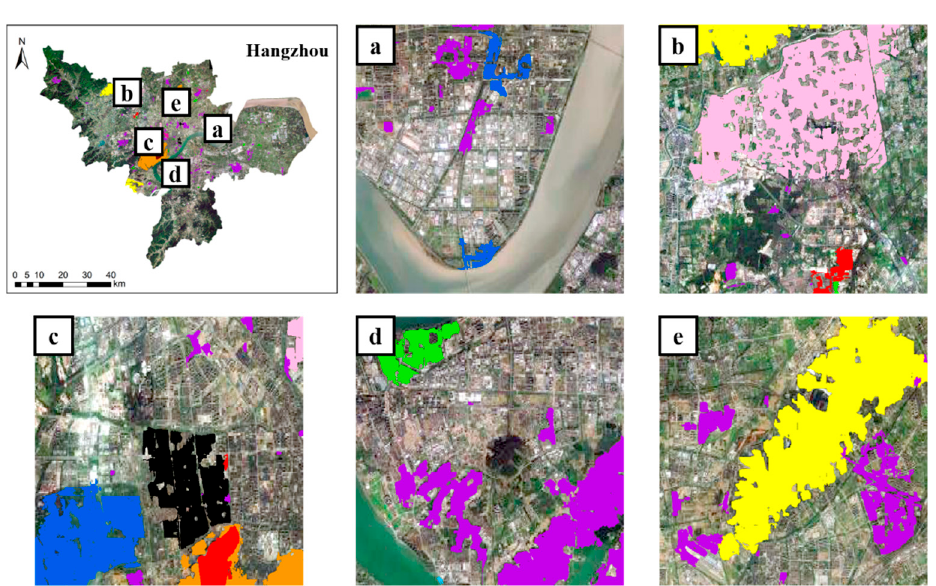
Figure 16. Local details of Hangzhou urban park map ( a – e ).